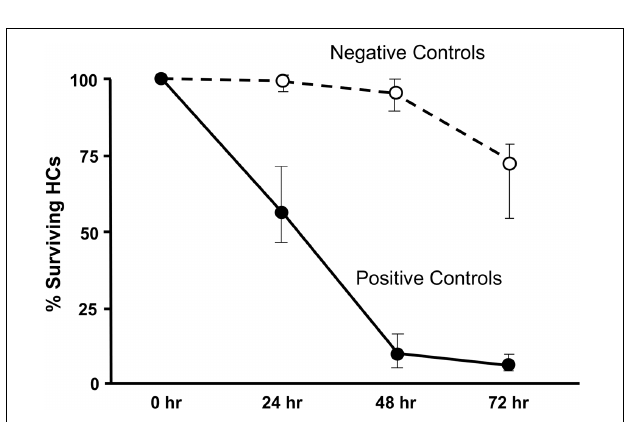
FIGURE 2 | Control culture cell counts. All of the positive and negative control oC micro-explants from all plates were counted and the results pooled to illustrate the control survival curves between D1 and D4. Data points represent medians, and error bars present the interquartile